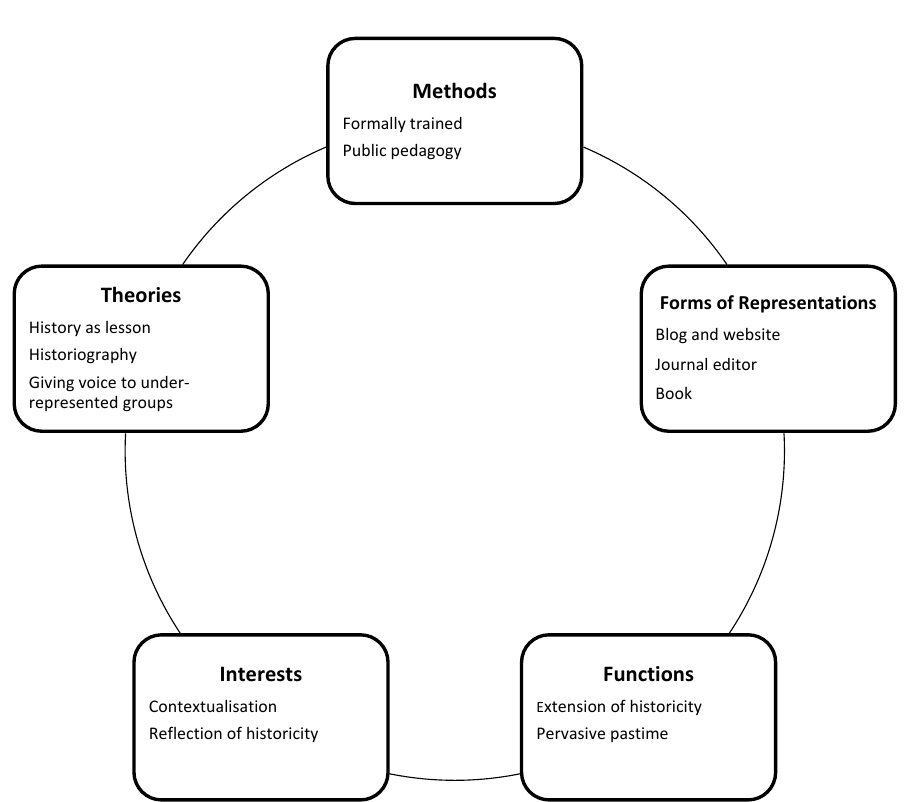
Figure 3. Case study two in alignment with Rüsen’s (1993) Disciplinary Matrix.